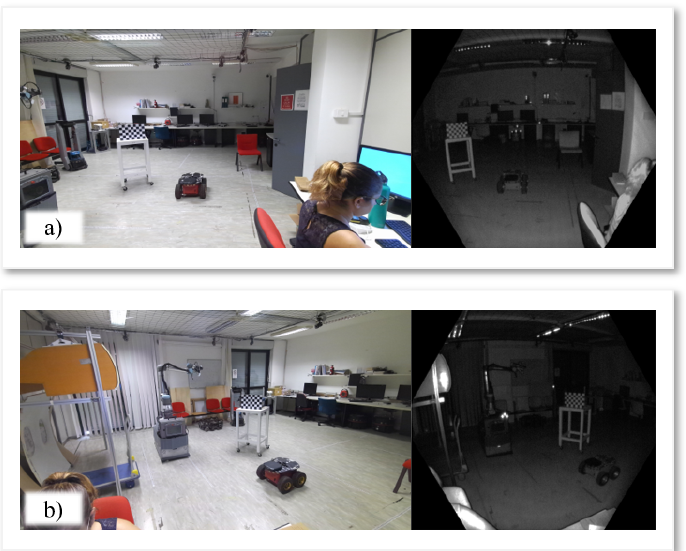
Figure 7. Views of the two Azure Kinects used during the experimentation, where ( a ) represents the Reference Camera, and ( b ) represents the Template Camera. More specifically, the images on the left in both ( a , b ) show the frames grabbed from the RGB sensors, while the images on the right show the frames grabbed from the IR